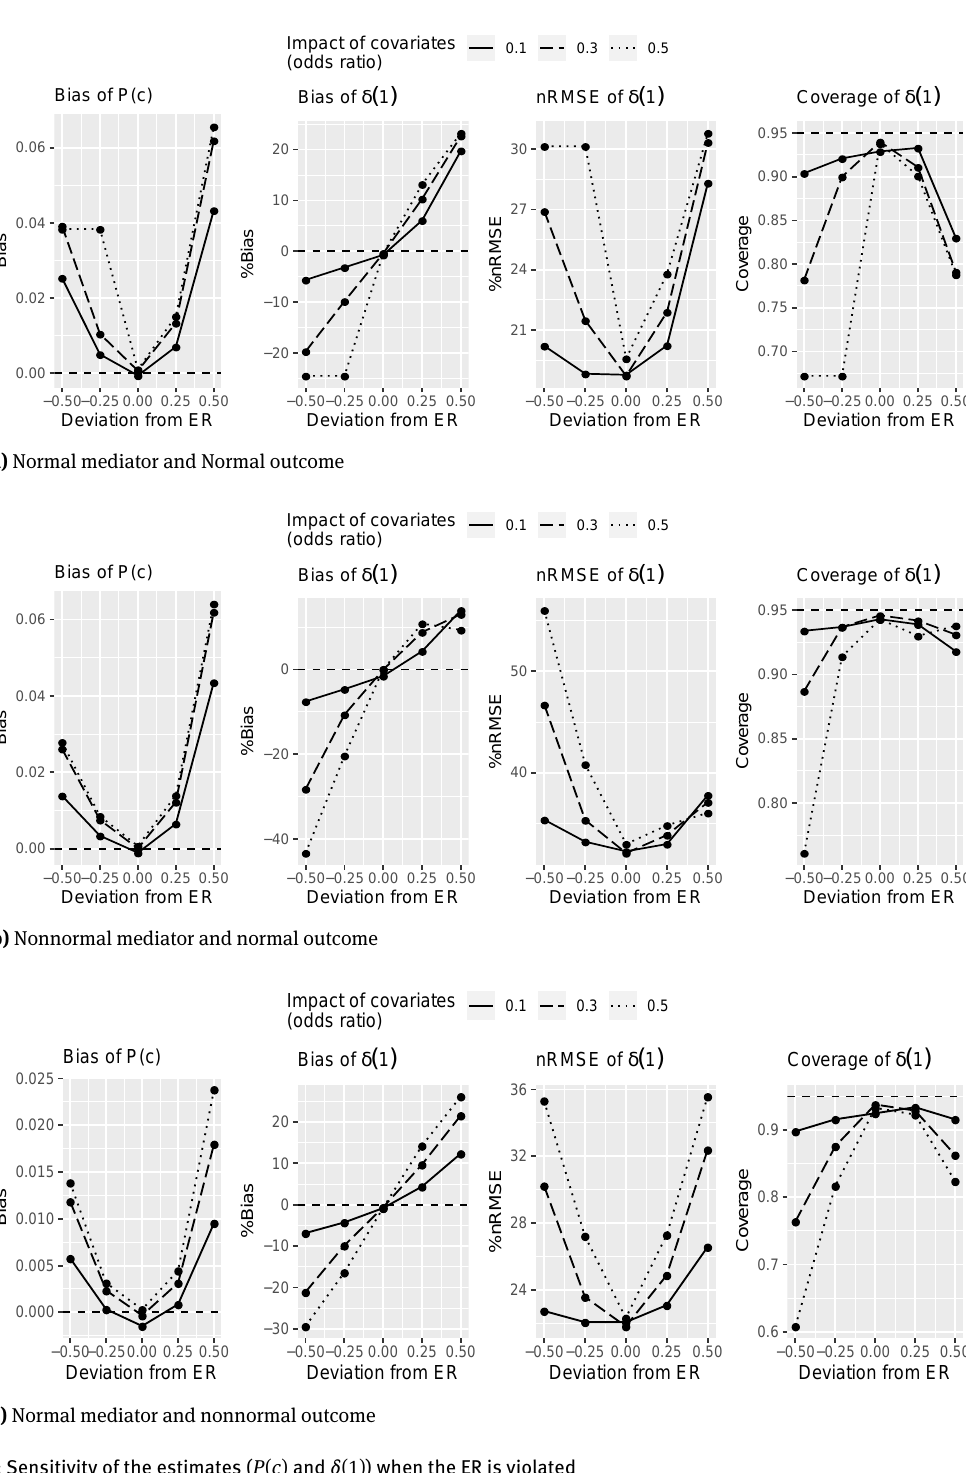
Figure 1: Sensitivity of the estimates ( P ( c ) and δ (1) ) when the ER is violated Note. 1) True effect: P ( c ) = 0.5 and δ (1) = 1 , sample size: 600. 2) The results for ζ (0) are similar to the ones for δ (1) . Given the similarity, we present the results for ζ (0) in the